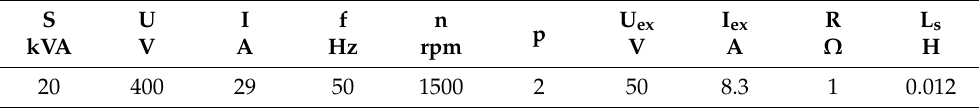
Table 1. SG parameters used in the